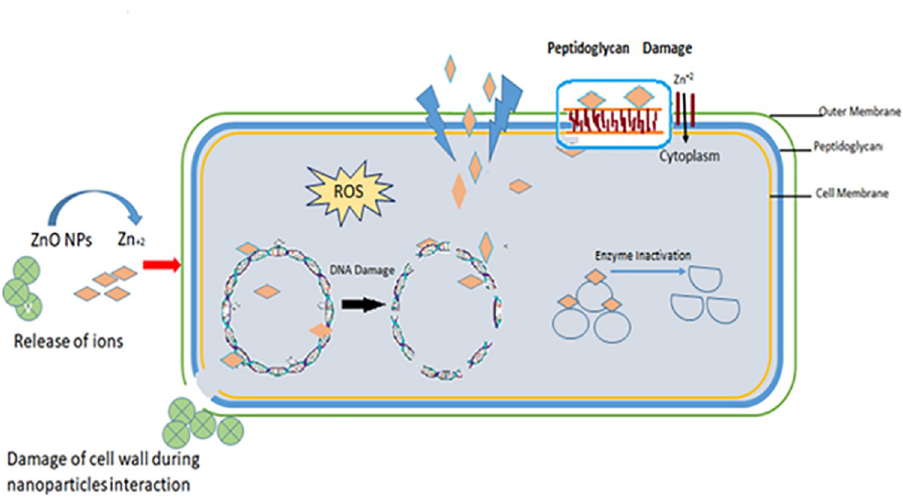
Fig 5. A schematic diagram of the antibacterial activity mechanism.